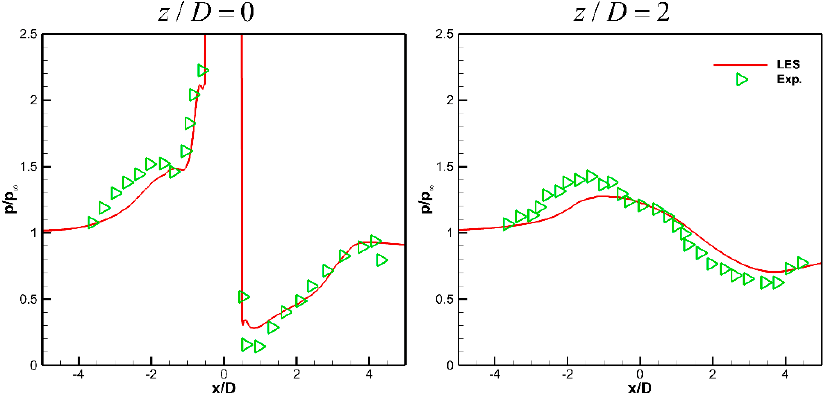
Figure 5. Comparisons of the mean wall-pressure 𝑝/𝑝 (cid:2998) distributions between the LES and the experimental data at 𝑧/𝐷 = 0 and 2; solid lines: LES, : Experimental.